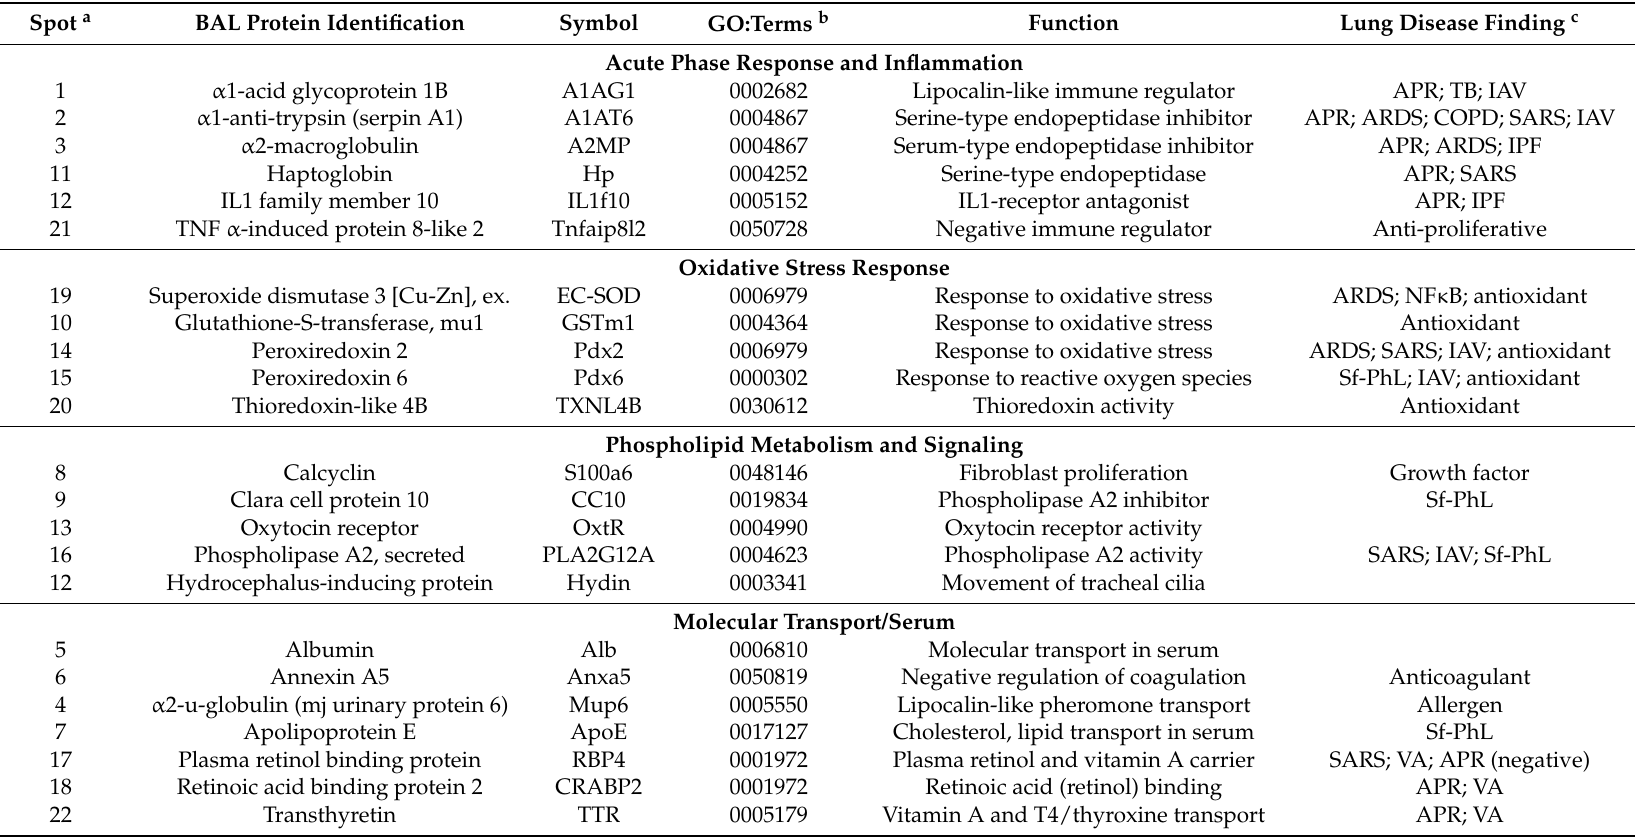
Table 1. Functions of bronchoalveolar lavage proteins identified in MHV-68 infection. Functions of constitutive and differentially-expressed proteins identified by proteomics from BAL fluid from mock (DMEM), MHV-68 infected, and MHV-IL6 infected mice, with selected findings in lung pathophysiology, inflammation